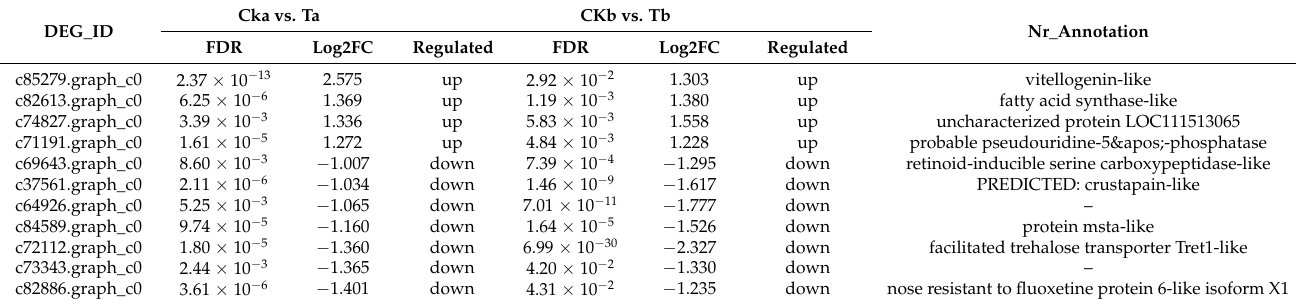
Figure 3. Venn diagram of differentially expressed genes after JHA application. CKa and CKb (controls)—1 and 2 days post-injection with carrier solution, respectively; Ta and Tb (treatments)—1 and 2 days post-injection with methoprene (2.5 µ g/ µ L), respectively. Table 1. Common 11 differentially expressed genes in CKa vs. Ta and CKb vs. Tb